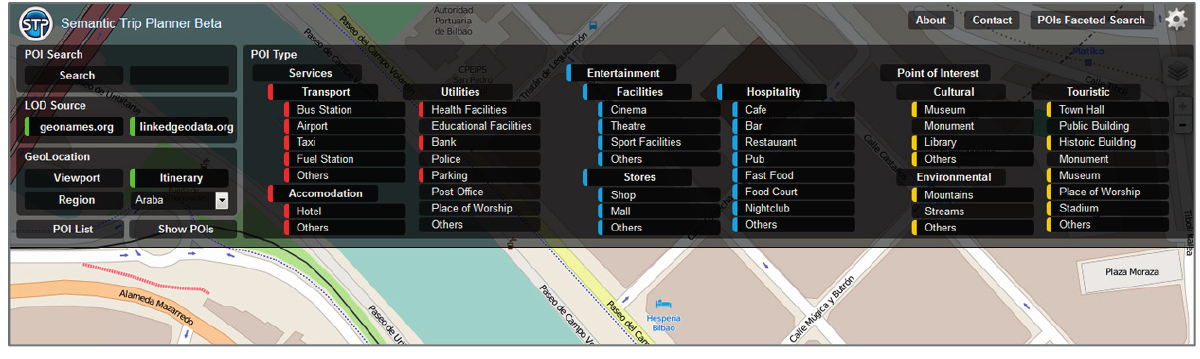
Figure 12. STP. Faceted search for the selection of POIs.